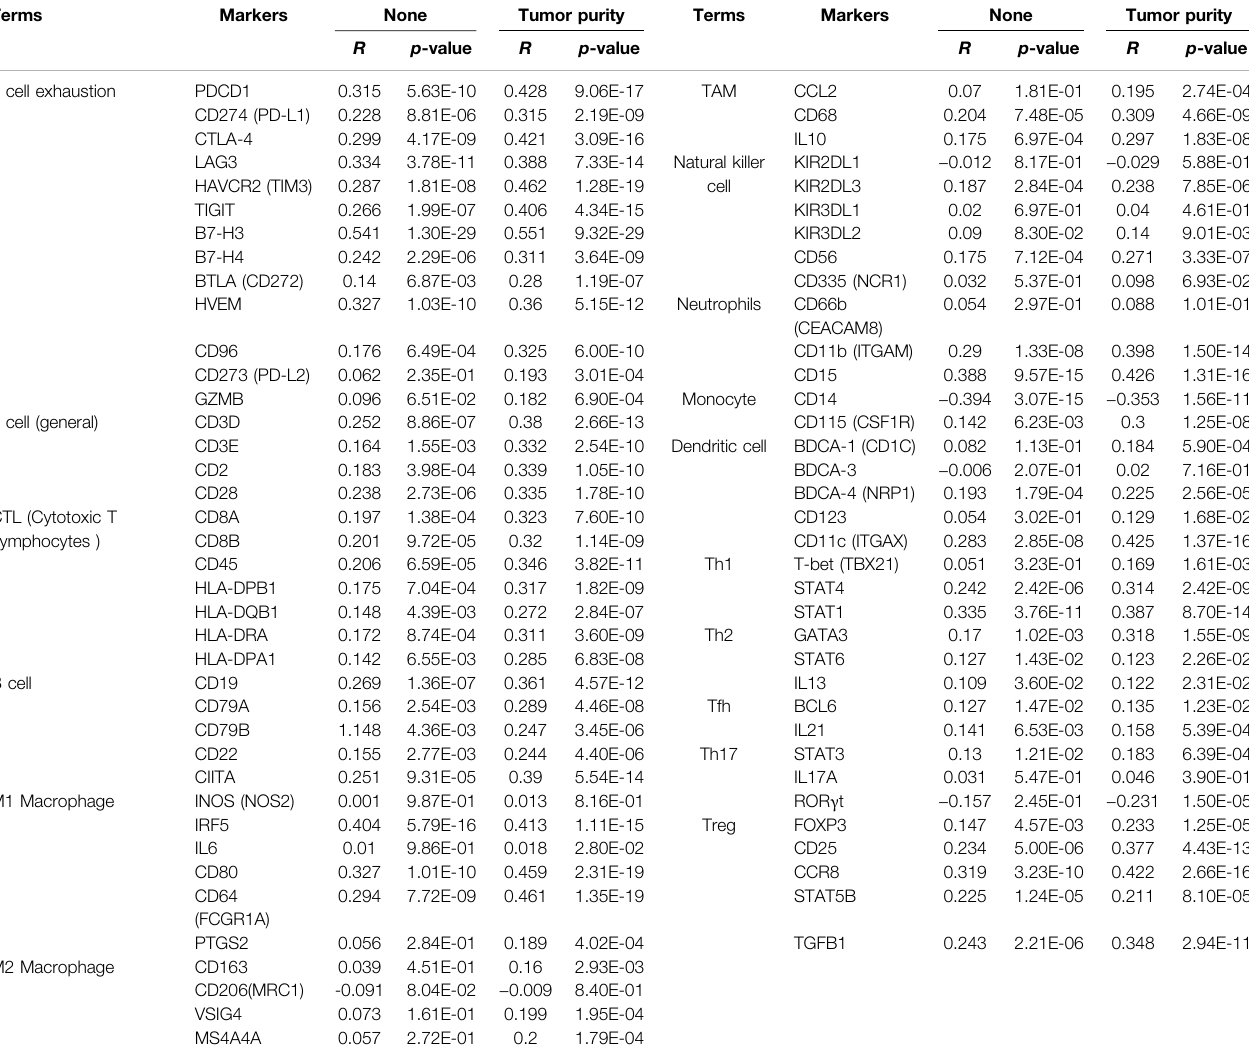
TABLE 4 | Correlation between ASF1B expression and immune marker sets of immune cells in HCC based data from TIMER database. Terms